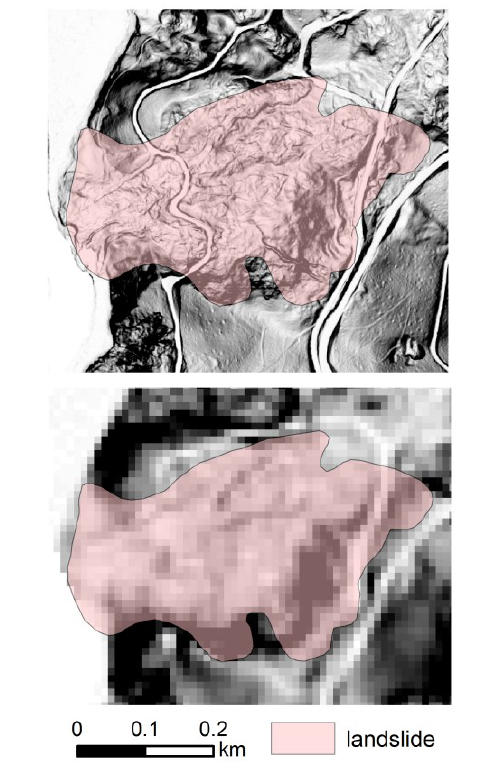
Figure 3 Landslide morphology